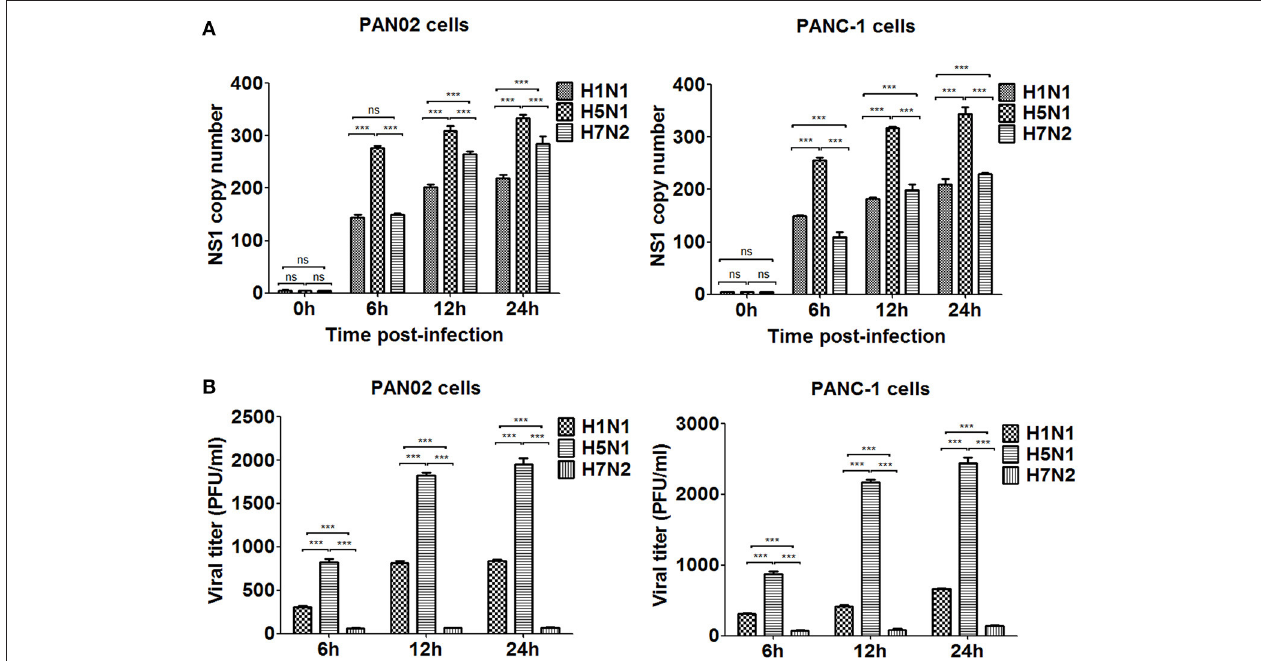
FIGURE 2 | H5N1 IAV could productively infect pancreatic cells while H1N1 and H7N2 showed limited replication. PAN02 and PANC-1 cells were infected with the three IAV subtypes at an equal multiplicity of infection (MOI) of 1 for the periods specified. (A) Cells were homogenized in Trizol reagent and the viral non-structural